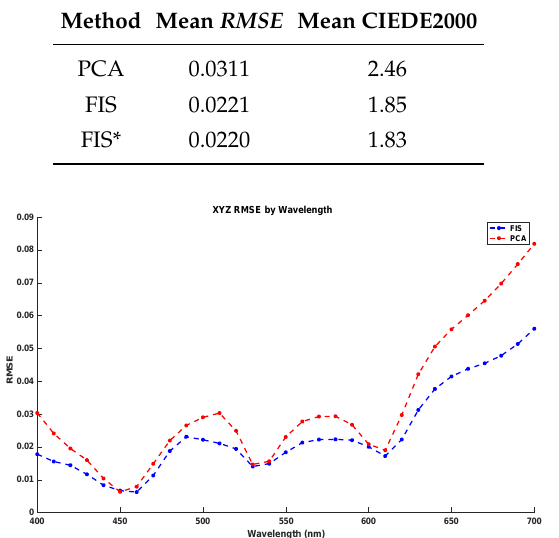
Table 2. Performance in spectral recovery from CIEXYZ for the reference PCA method and the build FIS method. We also include the FIS* variant where outputs multi-clusterization option is considered.